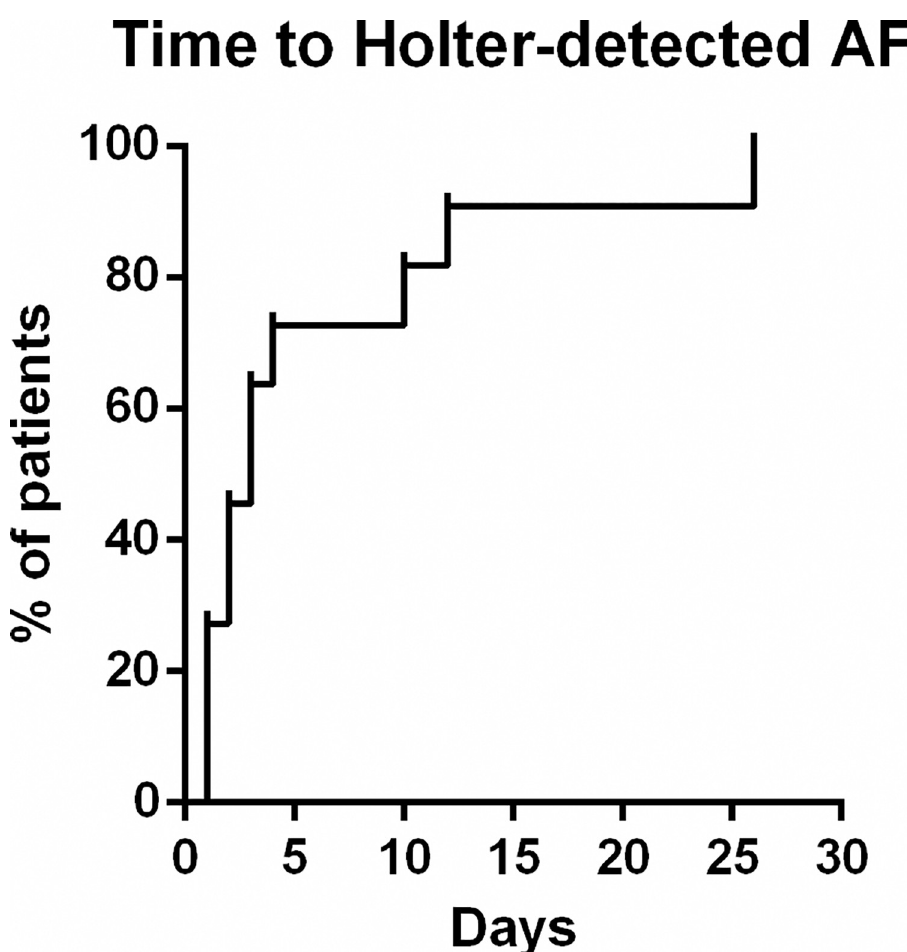
Fig 3. Kaplan-Meier curve reflecting the AF detection time within the patients with Holter-detected AF.